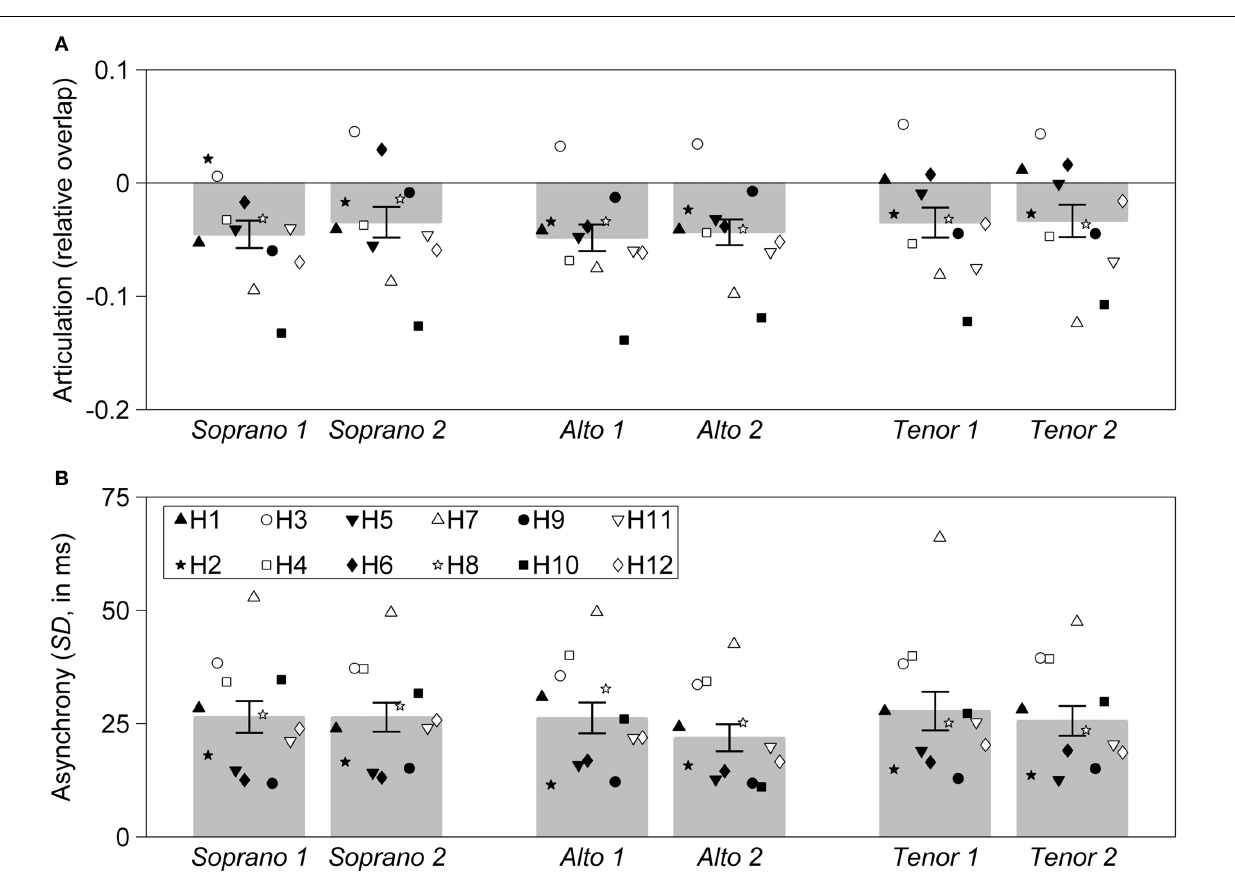
recordings indicated by the number “1” or “2.” Error bars represent the standard error of the mean. (A) Articulation, measured as relative overlap (negative values correspond to a detached articulation and positive values to a legato articulation). (B) Asynchrony, measured as the standard deviation of onset times for nominally synchronous notes (in